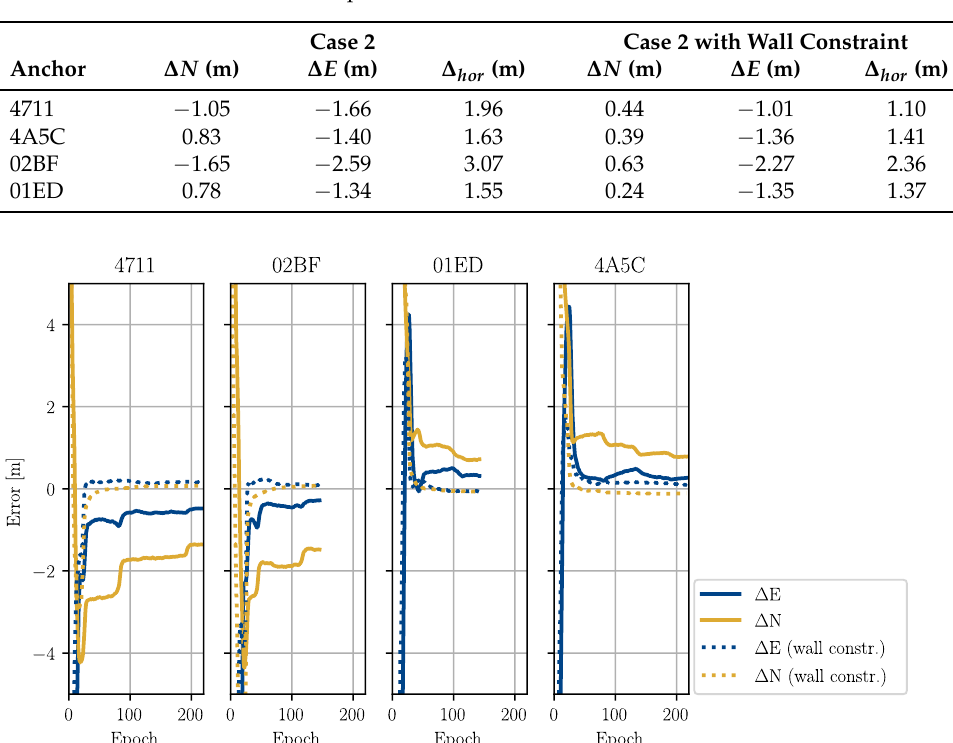
Table 6. Case 2: Error of the anchor position estimation based on test 5.